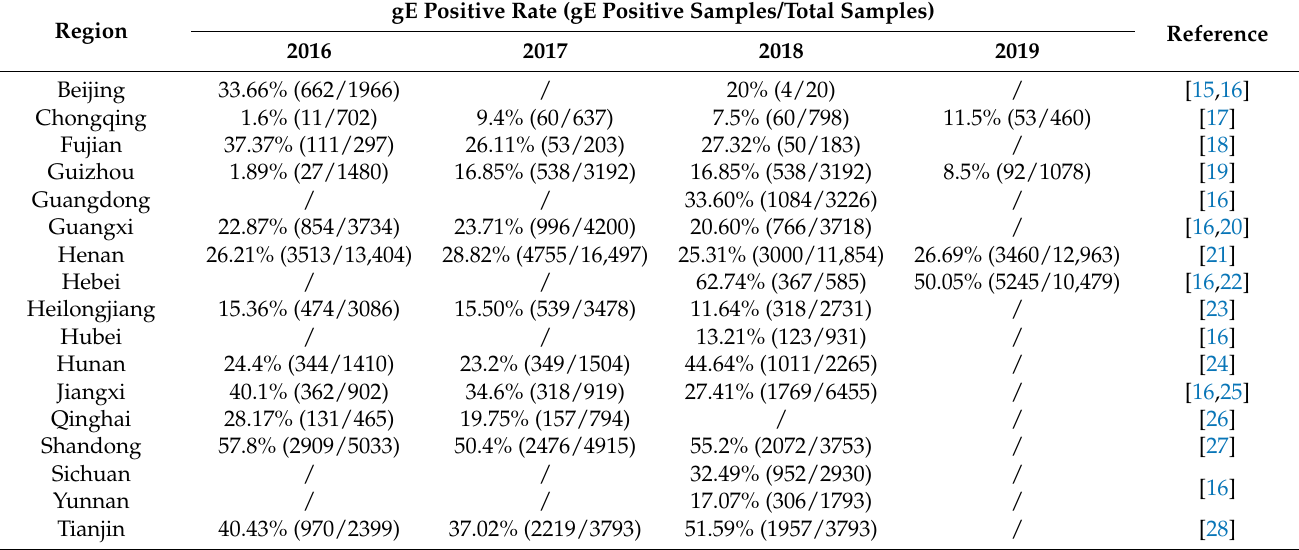
Table 1. The gE antibody positivity rate in different provinces in China. gE Positive Rate (gE Positive Samples/Total